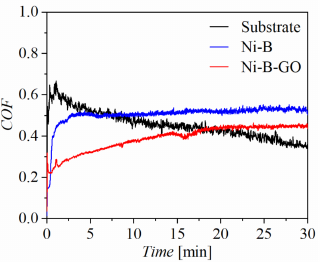
Figure 6. COF curves of the substrate, Ni-B coating, and Ni-B-GO